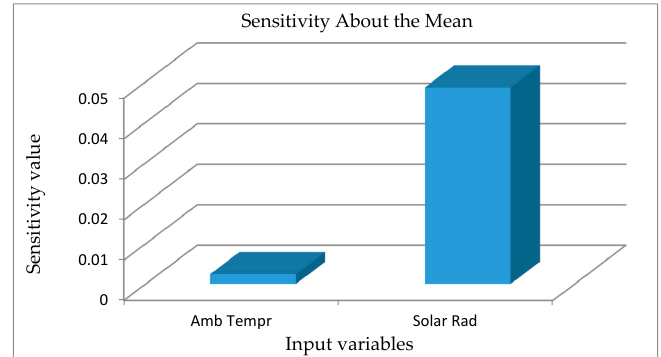
Figure 19. The sensitive analysis test for the SOFM network.